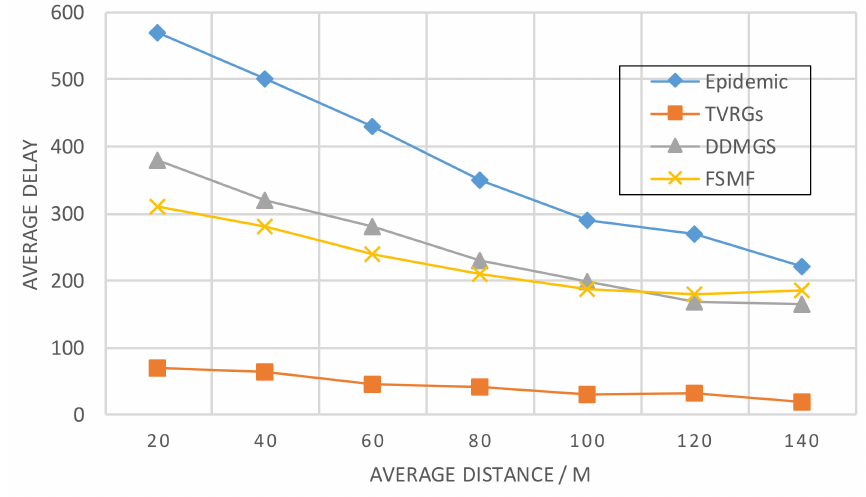
Figure 12. The relationship between average distance and average delay.